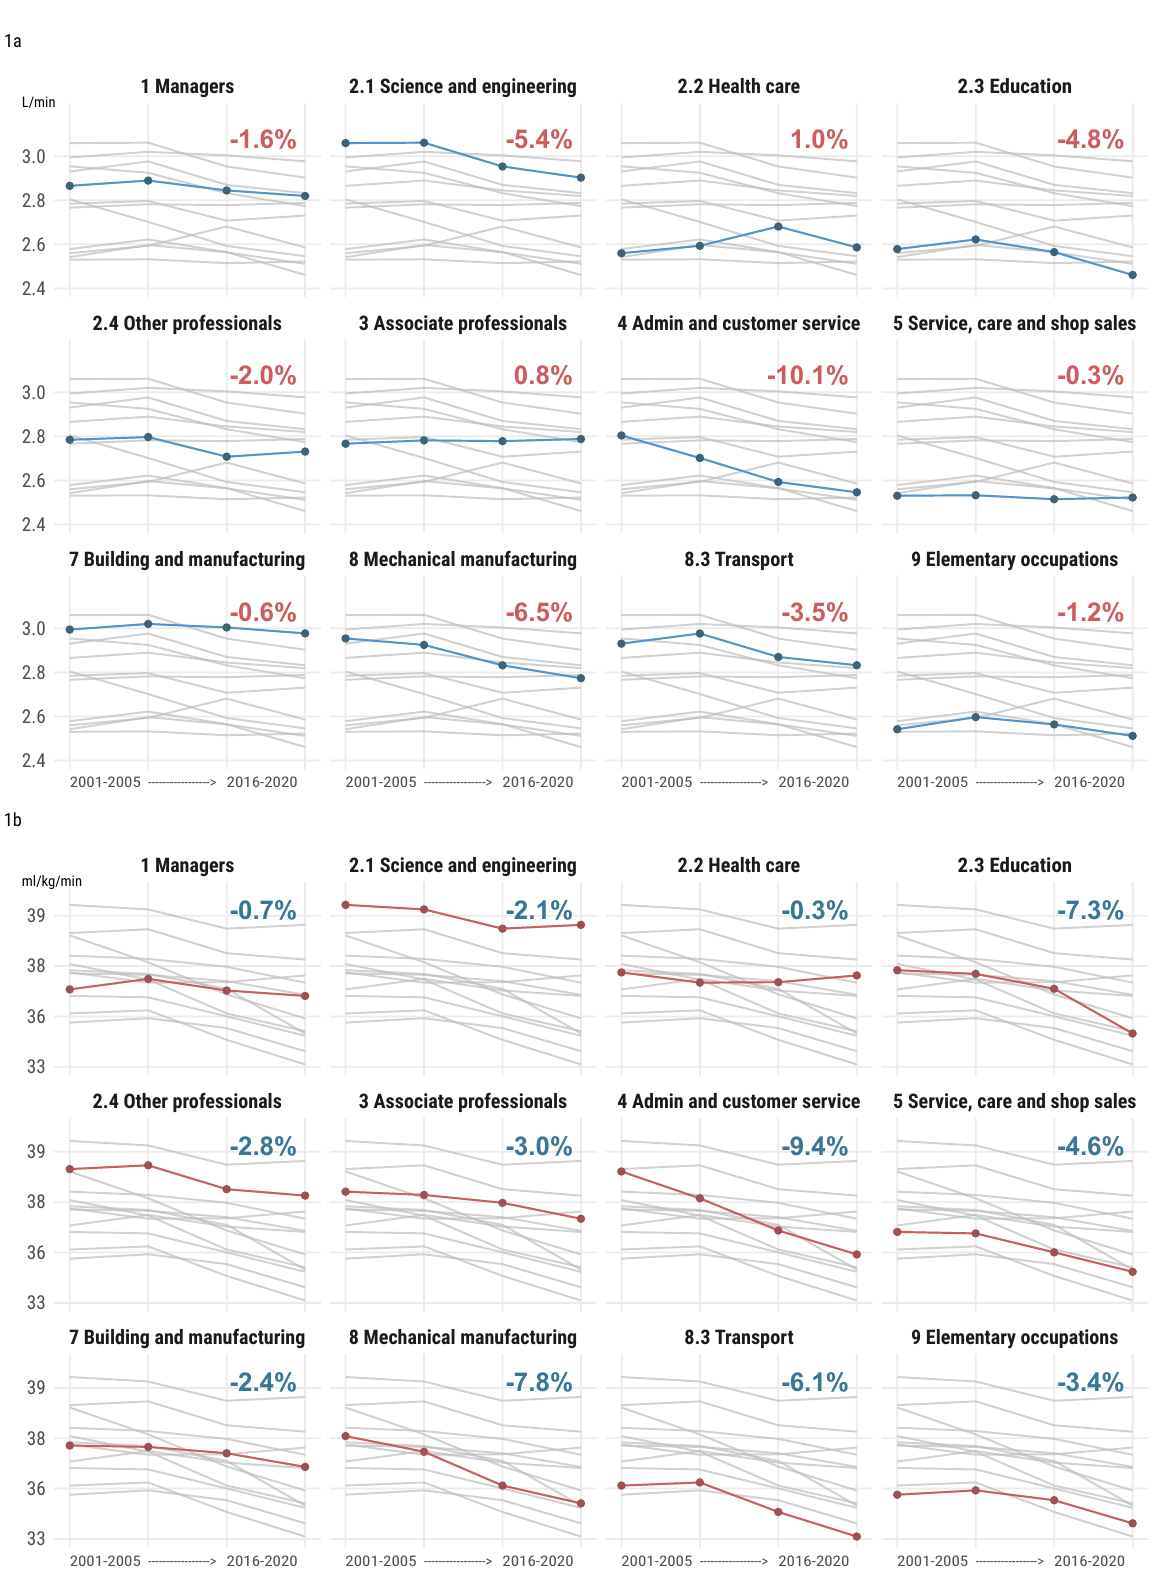
Figure 1. ( a ) Change in absolute CRF (L/min) and ( b ) relative CRF (mL/min/kg) in different occupational groups between 2001 and 2020. Gray lines show all other occupational groups. Percentages shown in the figure are change in CRF between the first and last 5-year